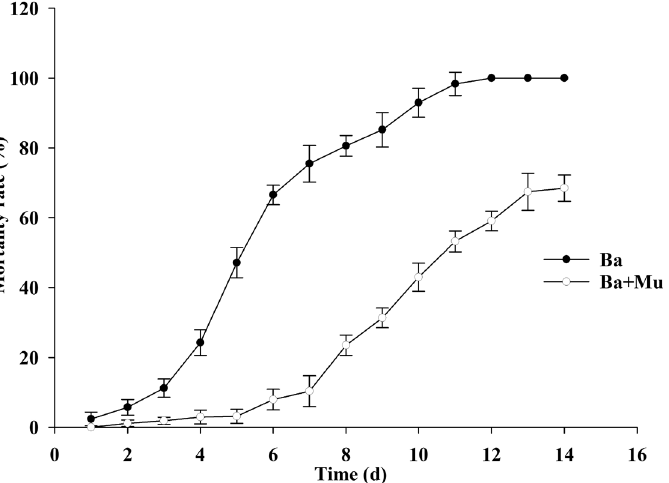
Figure 6. Comparison of the corrected mortality of A. hetaohei larvae infected by the B. bassiana treated or not treated with the epidermal mucus of the earthworm E. foetida . Ba: control group, the corrected mortality of A. hetaohei larvae were inoculated with the B. bassiana that was not treated with the earthworm epidermis mucus. Ba + Mu: the corrected mortality of A. hetaohei larvae were inoculated with the B. bassiana that was treated with the earthworm epidermis